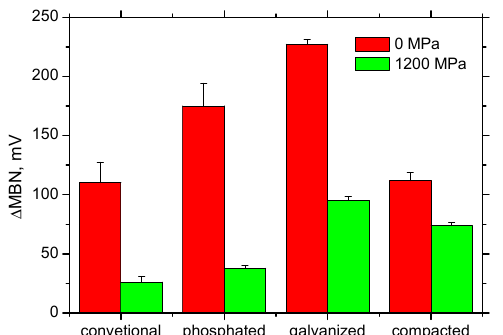
Figure 14. Variation of MBN– Δ MBN refers to the difference between the maximum and minimum value of MBN found in four different positions. Table 2. Distribution of microhardness HV0.2 in the wire subsurface region